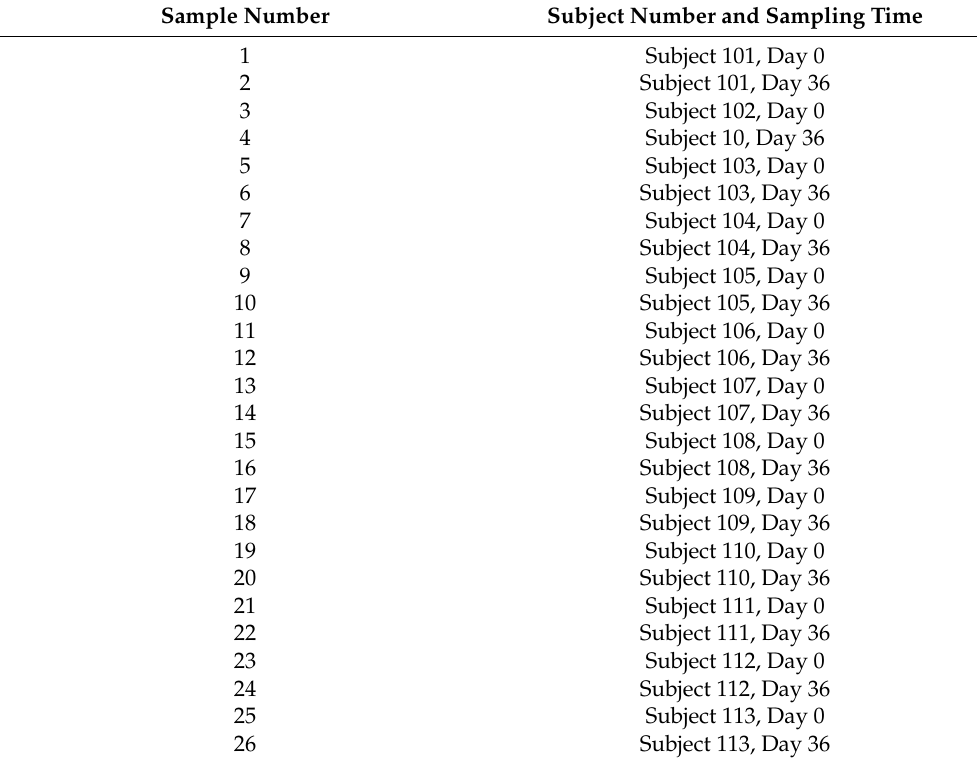
Table 1. Coding of the serum